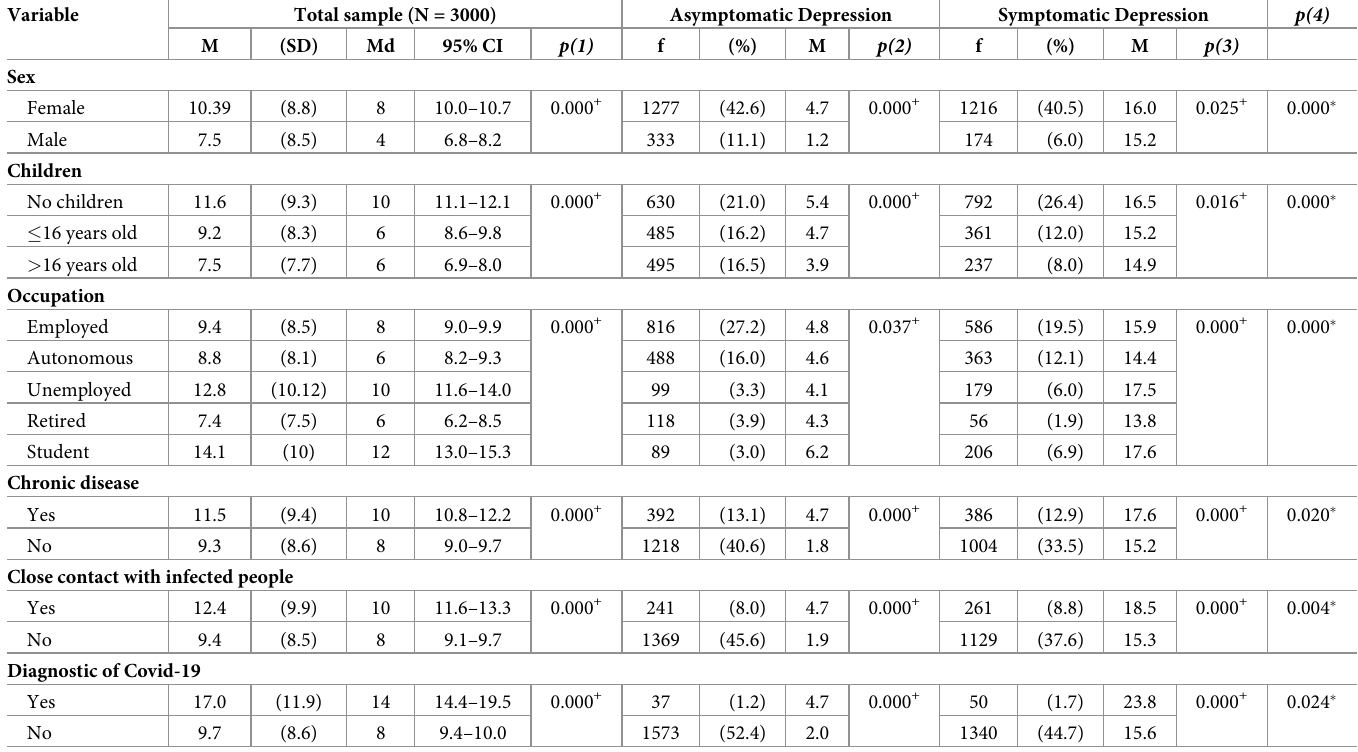
Table 3. Comparison of symptomatic and asymptomatic groups for depression. Variable Total sample (N =